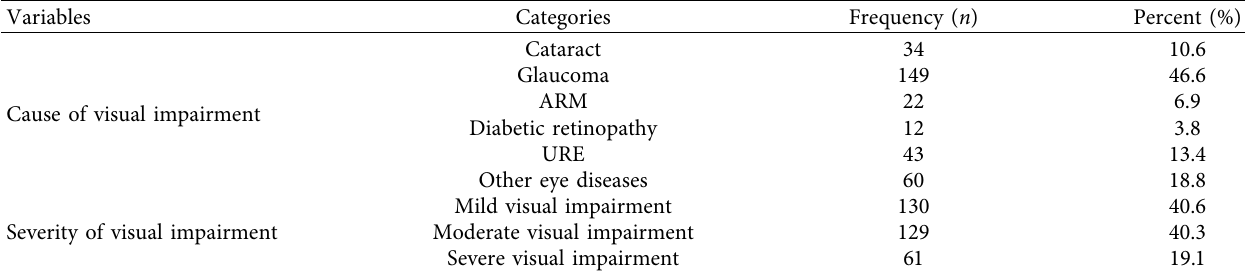
Table. 2: Vision-related characteristics of the study participant in Gondar, Ethiopia ( n �